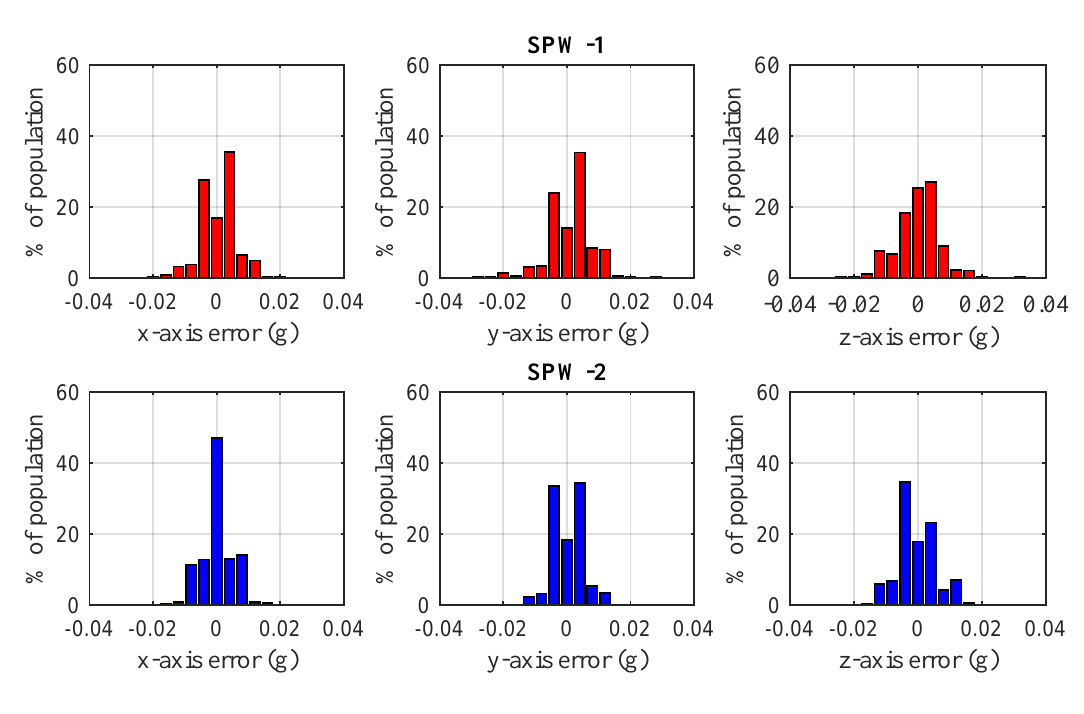
Figure 12. Noise levels of SPW-1 and SPW-2.